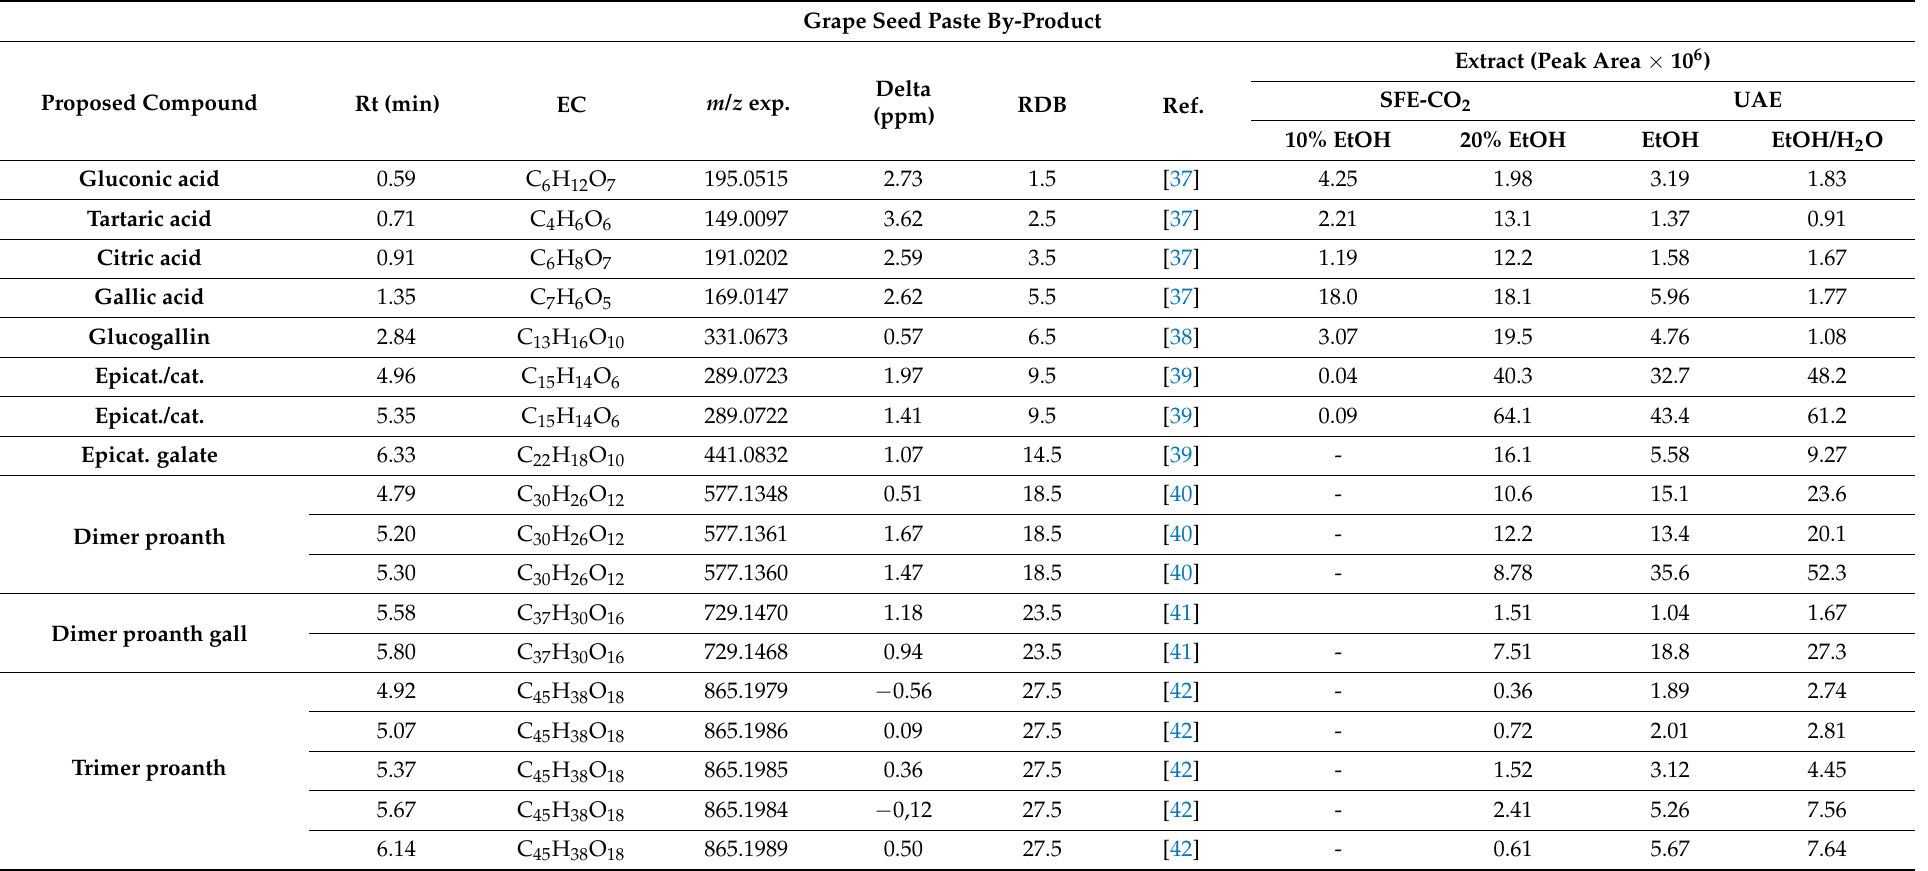
Table 2. The list of tentatively identified metabolites in the by-product seed extracts by Ultra Performance Liquid Chromatography equipped with Electron Spray Ionization source coupled with High Resolution Mass Spectrometer UPLC-ESI-HRMS/MS-orbitrap. Grape Seed Paste